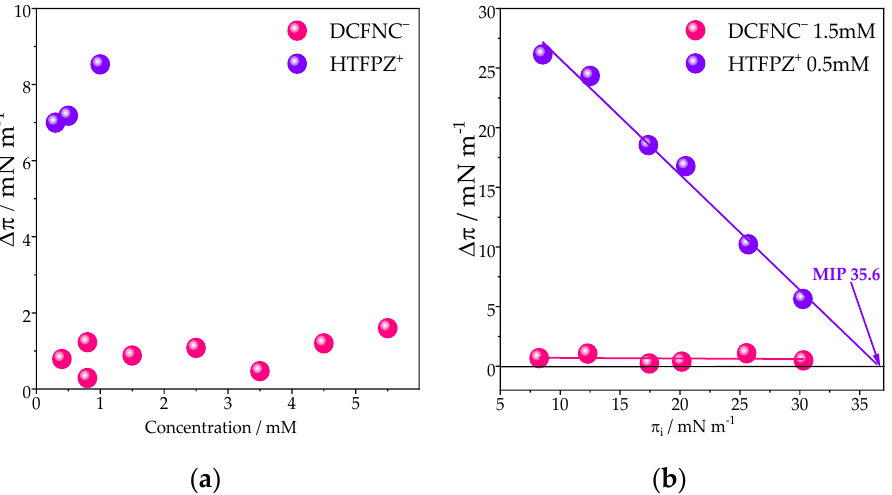
Figure 4. ( a ) Change in surface pressure ∆ π ( π f − π i ) as a function of the final drug concentration, film initial pressure 30 mN m − 1 and ( b ) Linear plot of the increment in surface pressure as a function of the initial surface pressure of the DSPA monolayer.